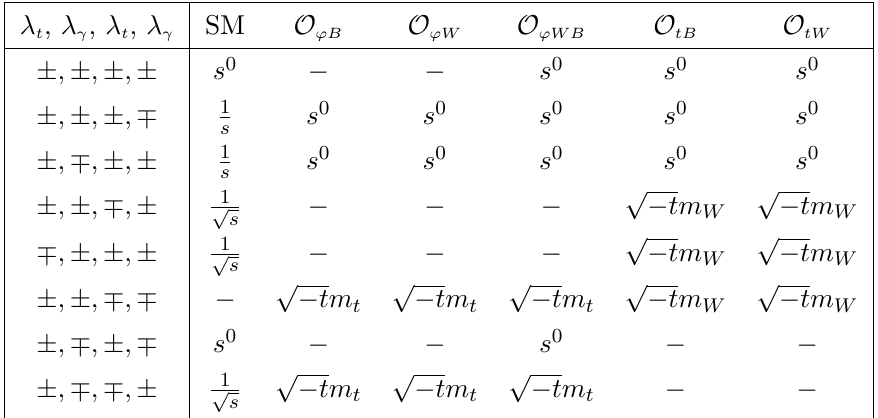
t v ) for t(cid:13) t(cid:13) scattering. (cid:24) (cid:0) (cid:29) ! ’ indicate any combination of ; . See (cid:3) (cid:6) (cid:7)